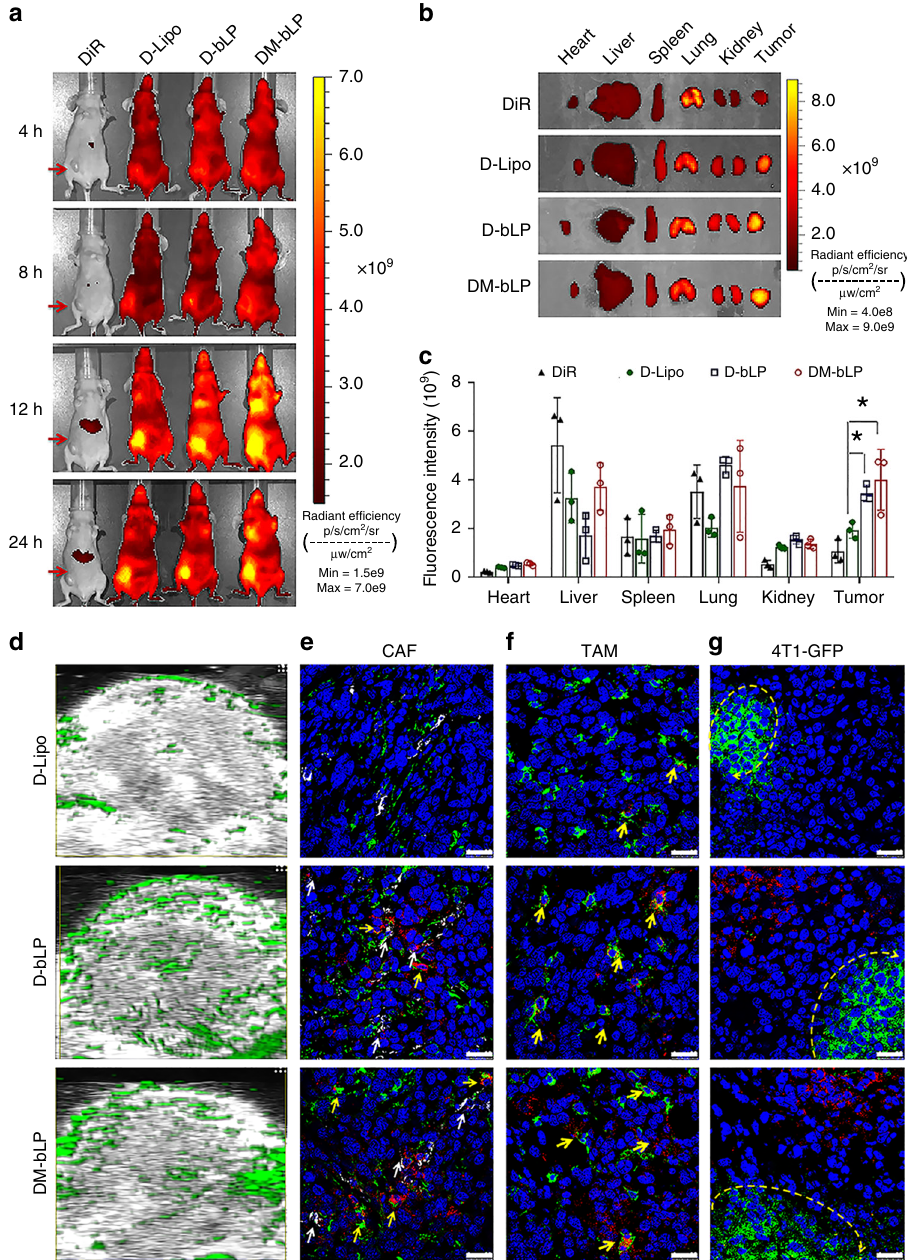
Fig. 3 The in vivo tumor targeting and internalization by various cells at tumor sites of the 4T1 breast cancer model. a Speci fi c accumulation of free DiR, D-Lipo, D-bLP, and DM-bLP at tumor sites (red arrows) by in vivo imaging system. b The ex vivo imaging of each group in major organs. c Quanti fi ed distribution of each group in major organs ( n = 3). The data are means± SD, * p < 0.05 (two-tailed Student ’ s t test). d Intratumoral distribution of various nanosystems measured by photoacoustic imaging (green signals in the captured images). e Internalization of various nanosystems by CAF at tumor sites. CAF was denoted as cells of α -SMA-positive (green signals) without co-localizing with CD31 (white signals) to avoid the interference of EC. Yellow arrows, CAF; white arrows, EC. f Internalization of various nanosystems by TAM at tumor sites. Green signals, TAM; yellow arrows, co-localization of nanosystems with TAM. g Internalization of various nanosystems by 4T1-GFP cancer cells at tumor sites. Green signals, 4T1-GFP cancer cells, yellow circle arc, 4T1-GFP cancer cells regions, scale bar, 25 µ